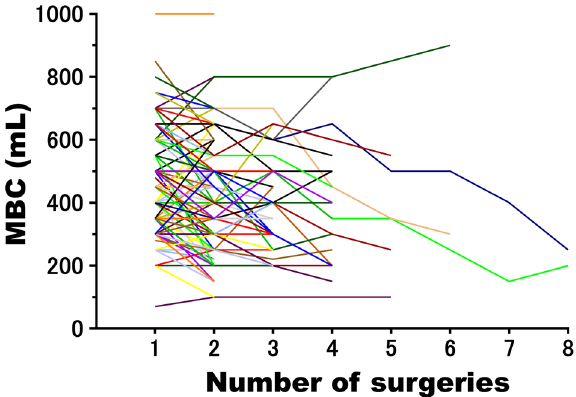
Figure 1. Spaghetti plot for MBC and the number of surgeries. Measurement of MBC over multiple sessions. Each colored line represents an individual patient.